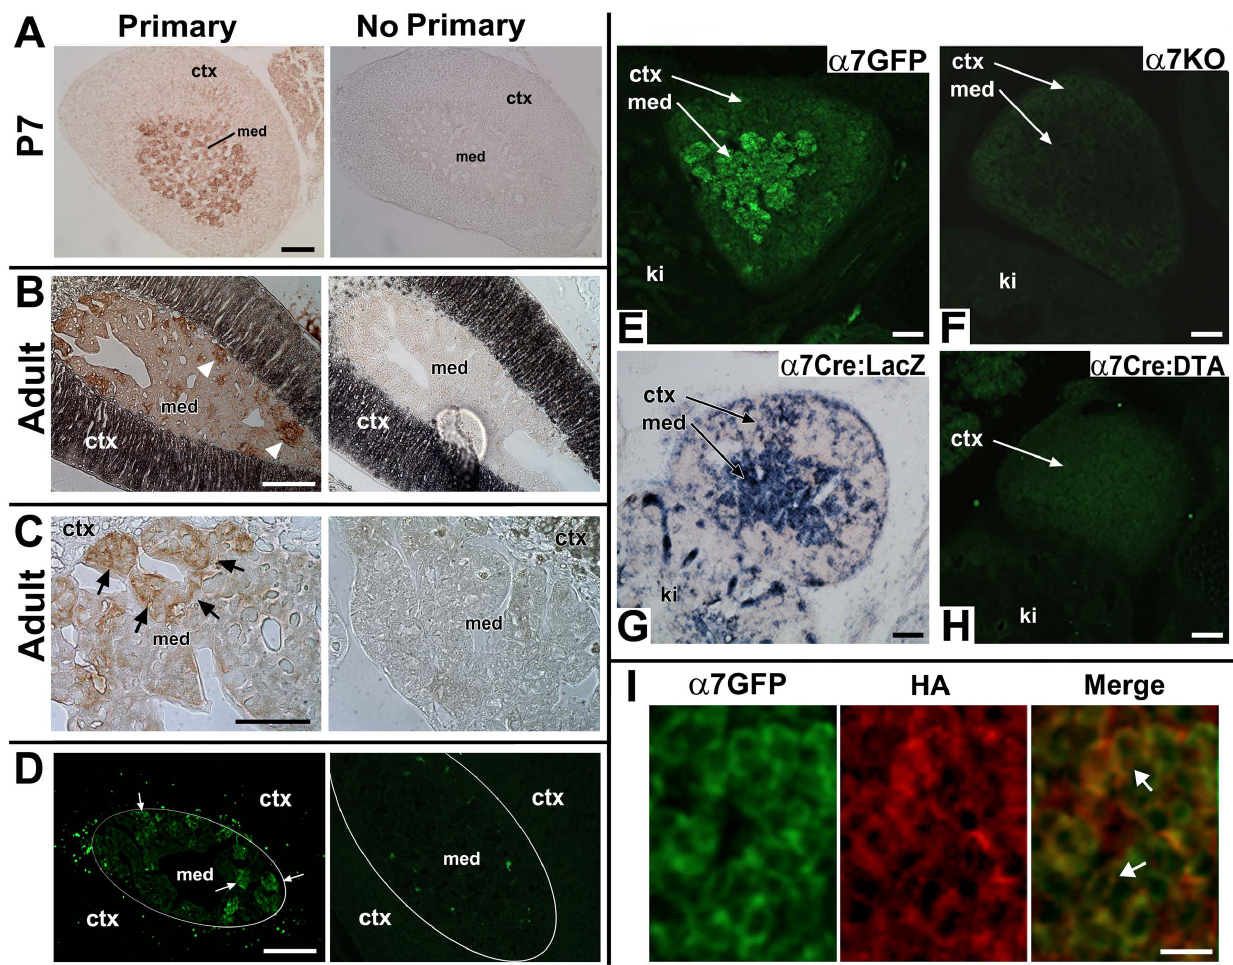
Figure 1. Specificity of a 7 G detection in the adrenal gland. A . Transverse sections from a post-natal day 7 (P7) a 7 G mouse adrenal gland. Anti- GFP (Primary) labeling using the immuno-peroxide method reveals cells localized throughout the adrenal medulla (med) that exhibit expression. Cells in the adrenal cortex (ctx) were not labeled. On the right is a similar section that was processed but the antibody to GFP was omitted (No Primary). B . Transverse sections from an adult a 7 G adrenal gland processed for GFP immunoreactivity as in A. On the right an adjacent section was processed without addition of anti-GFP primary antibody. Arrow heads identify cells immunopositive for GFP signal which tend to be in clusters near the boundary of the medulla and cortex (darkly colored in this preparation). C . Increased magnification of the adult adrenal gland medullary region showing immune-reactivity towards GFP. The arrows point to cell clusters expressing GFP indicative of a 7 G expression. The section to the right was again processed the same way but with omission of primary antibody. D . Transverse sections from an adult a 7 G mouse adrenal gland were processed using immunohistochemistry to reveal anti-GFP immunofluorescence. On the right is a section processed without addition of anti-GFP primary antibody. Arrows identify a 7 G cells immunopositive for GFP signal. The white oval outline approximates the boundary between the med and ctx. Note the similarity between the immunofluorescence pattern of GFP expression in cell clusters near the medulla-cortex boundary that closely resemble the pattern of immune-staining seen in B and C using the immuno-peroxide method. E–H . Additional tests confirm the specificity for measurement of the a 7 G expression pattern in the adrenal gland. E . Sections were taken from E14.5 embryos of various genotypes related to a 7 expression. First, immunofluorescence to a 7 G ( a 7GFP) is revealed using and anti-GFP primary antibody. The anti-GFP signal is prominently expressed in chromaffin cells of the developing adrenal medulla (med), but it is essentially absent from the adrenal cortex (ctx). The kidney is identified (ki). F . A similar section was prepared from an a 7 knock-out ( a 7KO) adult mouse and processed for anti-GFP immunofluorescence. No detectable GFP signal was observed. G . Another independent method to measure a 7 expression was tested in an E14.5 embryo from the a 7 Cre to a Rosa26-loxP(LacZ) reporter mouse cross ( a 7Cre:LacZ; for details see [28]). This embryo exhibits beta-galactosidase staining consistent with chromaffin cell expression. H . Sections prepared from E14.5 embryo of the a 7Cre x Rosa26-LoxP(diphtheria toxin (DTA) cross to conditionally ablate ( a 7Cre:DTA; see [28]). Anti-GFP immunofluorescence detects no a 7 G and there is no defined adrenal medulla (compare with E). I . In an E18.5 a 7 G embryo the co-labeling for GFP ( a 7GFP; green) and the a 7-associated hemagglutinin epitope tag (HA; see [28]) reveals GFP (green) that diffuses throughout the cytoplasm but does not enter the nucleus. The HA immunostaining (red) is located on the cell surface of the GFP expressing cells usually in a punctate pattern (identified by arrows). For A–H the Bar =100 m m and for I the Bar =30 m m.